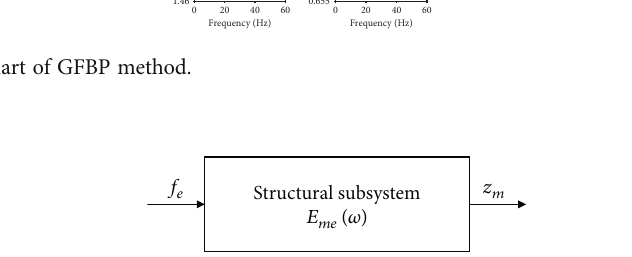
Figure 2: Structural